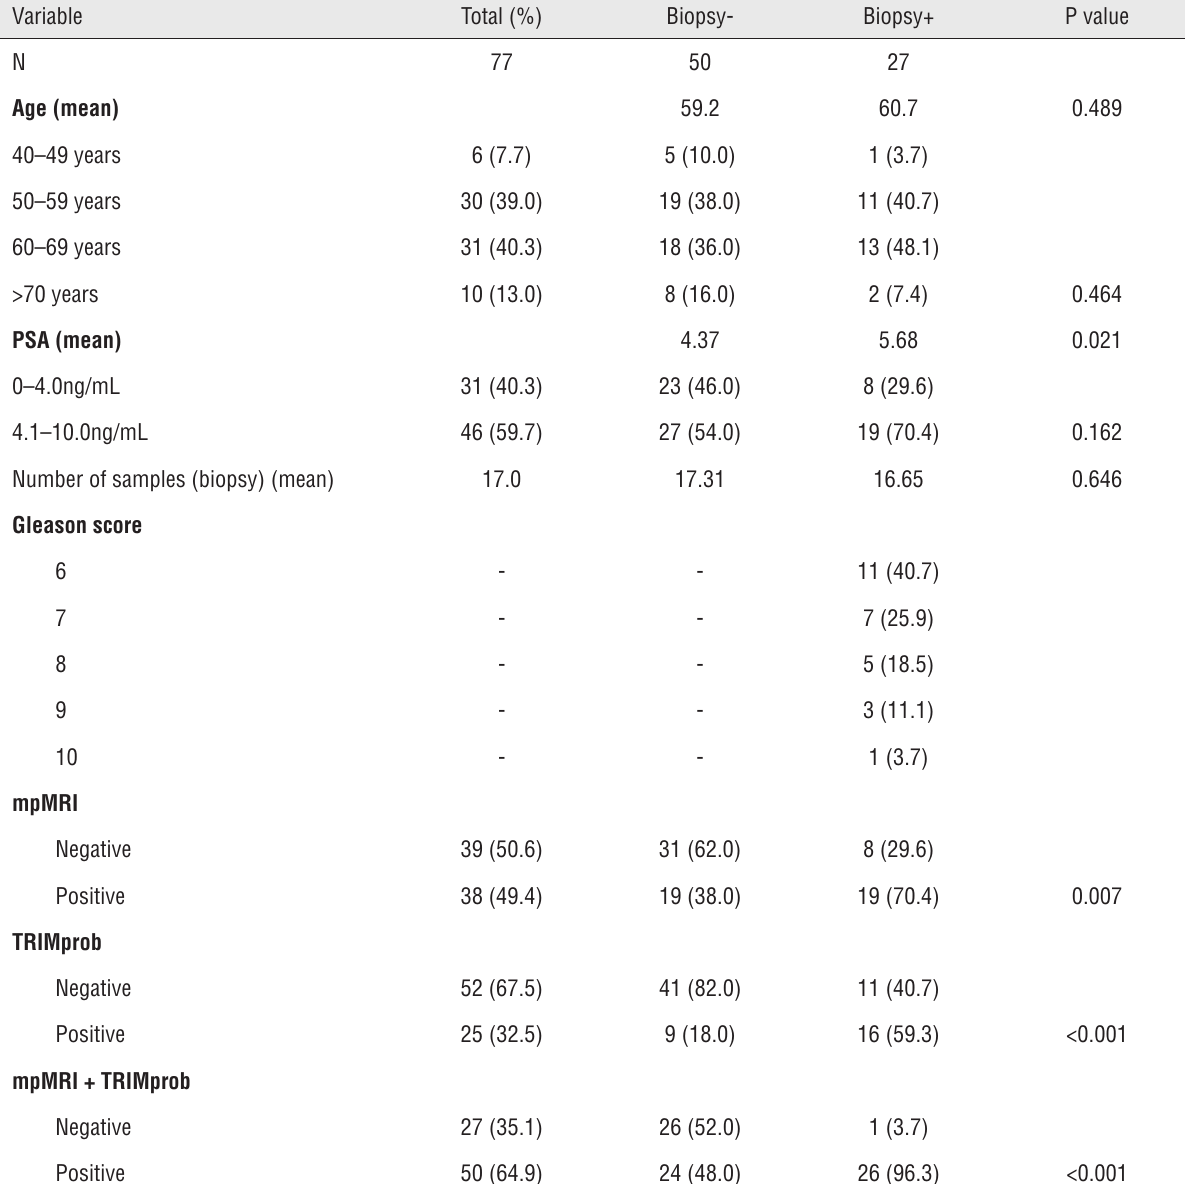
Table 2 - Clinical and pathological characteristics of 77 patients submitted to prostate biopsy.